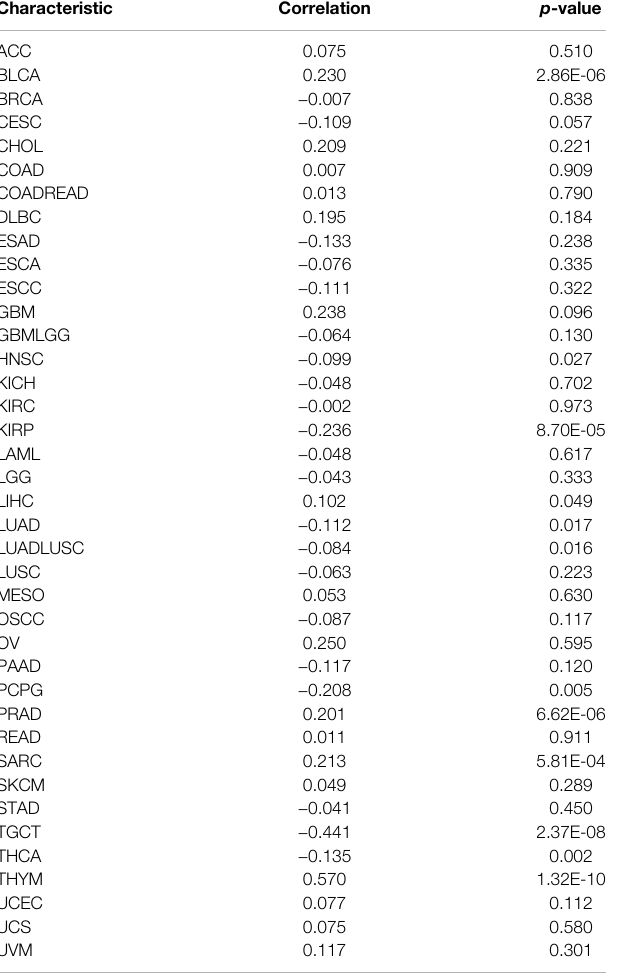
TABLE 1 | Relationship between BCL7B gene expression and DNA methylation (Illumina methylation 450 data and cg27441048 probe) in pan-cancer.